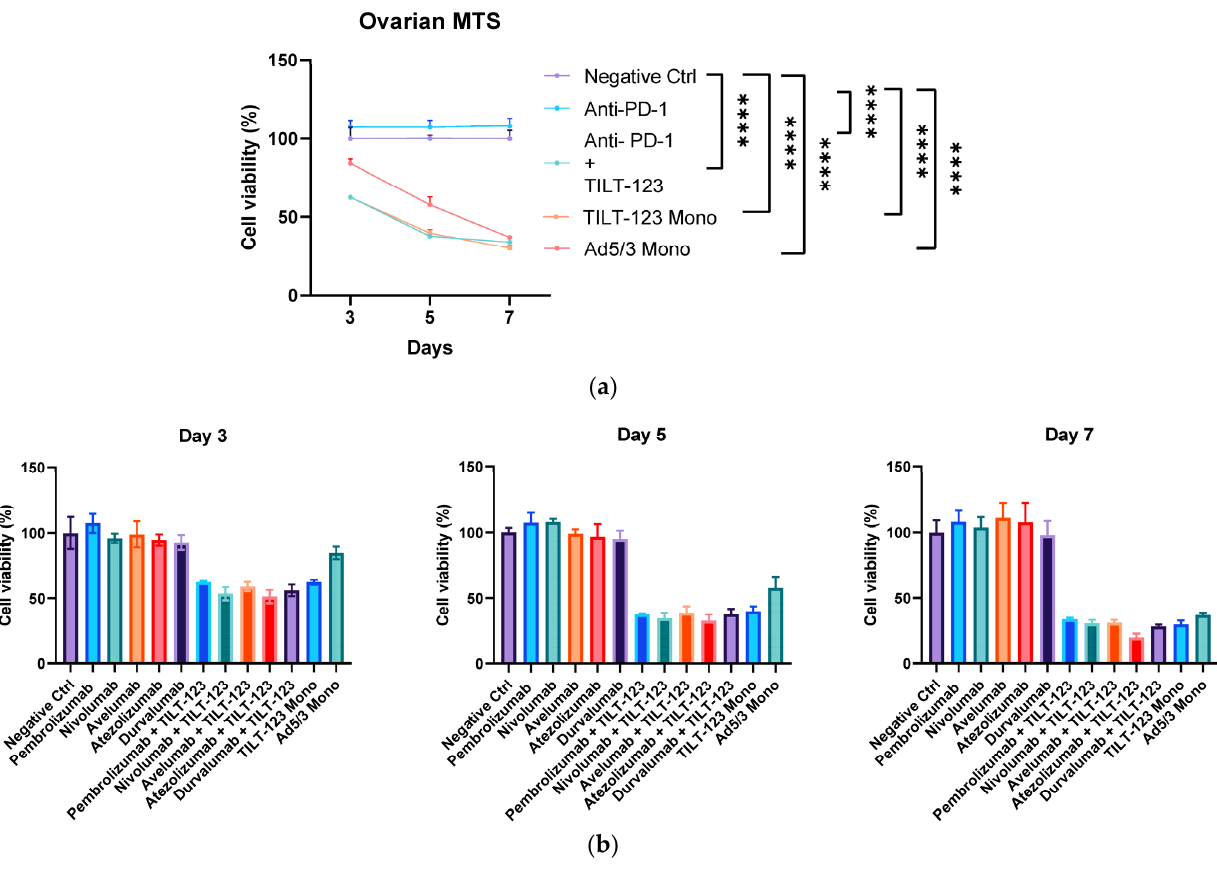
Figure 1. Ovarian cancer cell viability after virus and/or immuno-checkpoint inhibitor treatments. ( a ) HUSOV4 patient sample cancer cells were treated with; media (negative control), Pembrolizu- mamb 20 mg/mL, TILT-123 virus (100 VP/cell), or with a combination of pembrolizumab plus TILT-123 virus. Controls were left untreated. ( b ) TILT-123 virus cytotoxicity in ovarian cancer cells when administrated as a monotherapy or in combination with most commonly used human PD-1 and PD-L1 antibodies. All ICI antibodies were used as 20 mg/mL. MTS assay was performed as mentioned above, with same concentrations but several different ICI. Statistics; One way ANOVA (Tukey’s multiple comparison) was used for statistics on day 7 (**** p ≤ 0.0001). Data has been gathered as triplicates and is presented as mean +